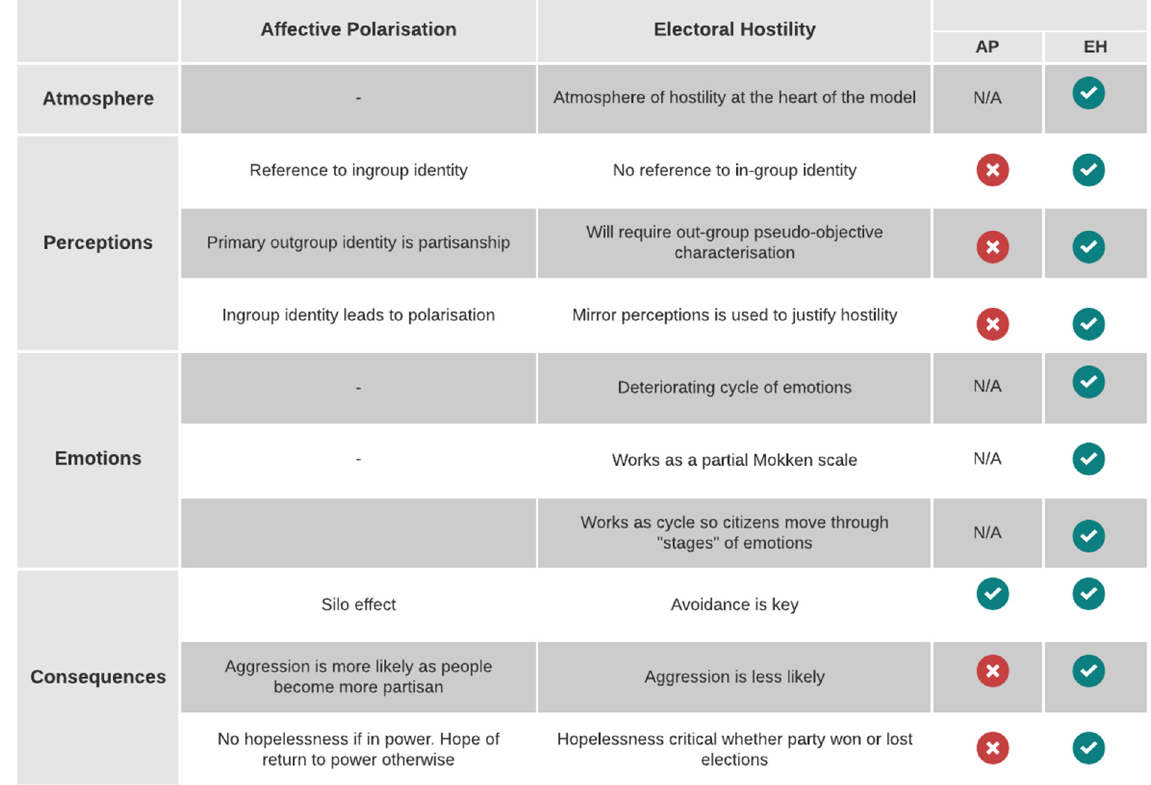
Figure 2. Summary: AP vs. EH.